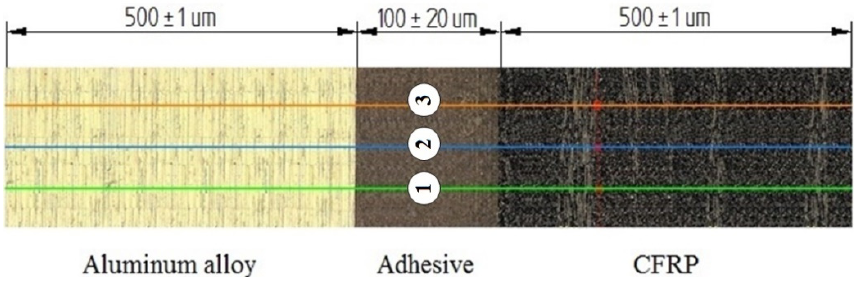
Figure 6. Measuring length with three measuring points.